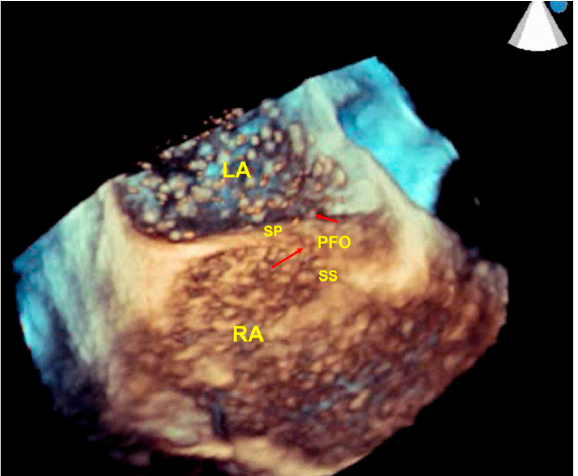
Figure 2. A 3D-TEE real-time microbubble test. Microbubbles opacify the right atrium (RA). Several microbubbles (red arrows) pass through the PFO, reaching the left atrium (LA) from the RA. SP: septum primum; PFO: patent formen ovale; SS: septum secundum; CN: Chiari network; RA: right atrium.